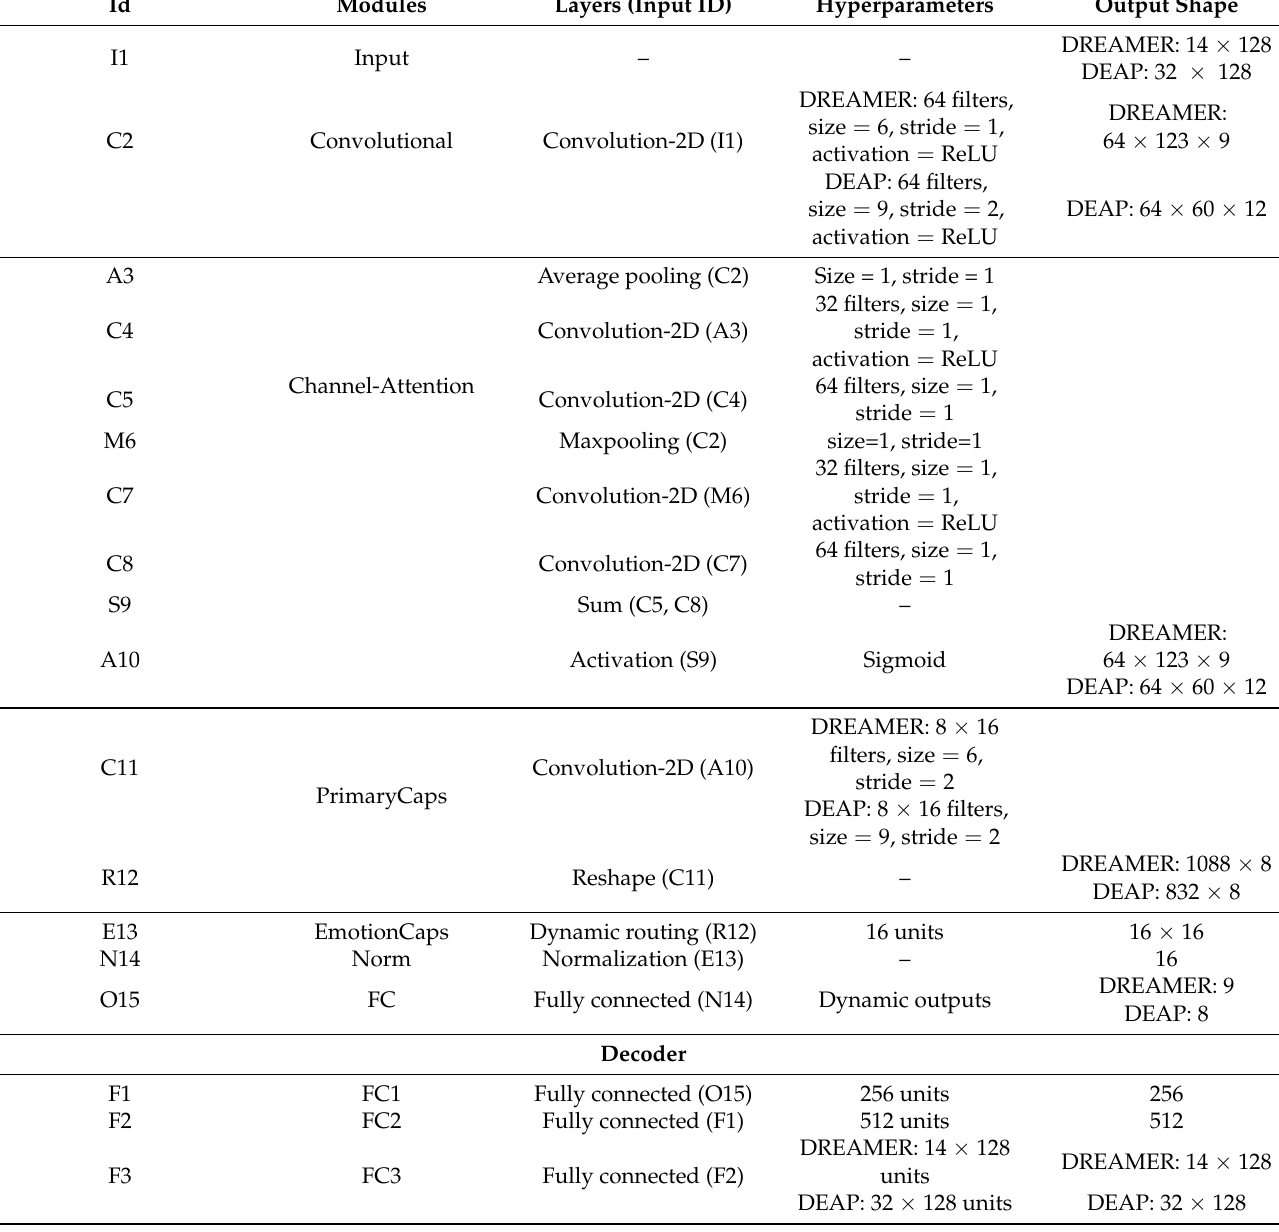
Table 1. Specifications of the Capsule Network architecture. We include a Channel-Attention block before the PrimaryCaps module. The decoder setting for reconstruction loss is shown at the